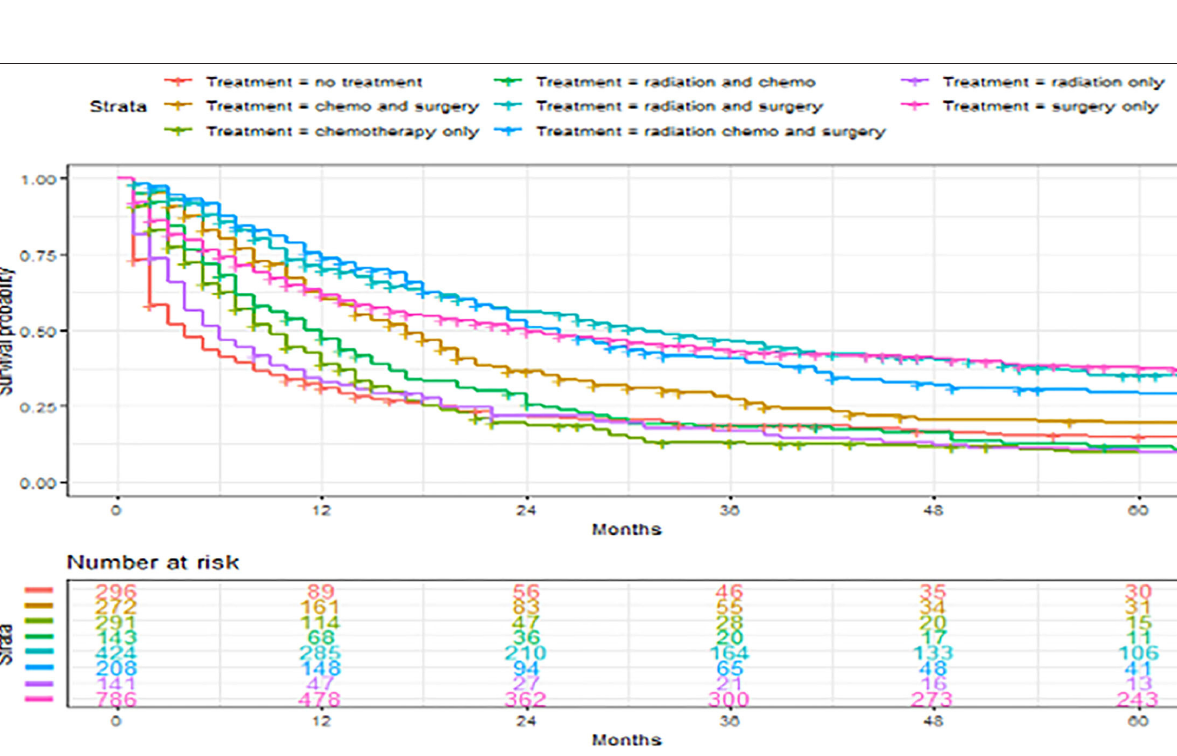
Frontiers in Surgery |